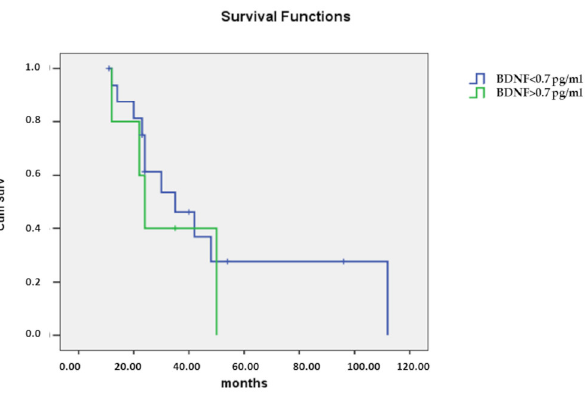
Figure 4. Kaplan-Meier survival curves in relation to CSF BDNF levels. Blue line: BDNF < 0.7 pg/mL; green line: BDNF concentration > 0.7 pg/mL.